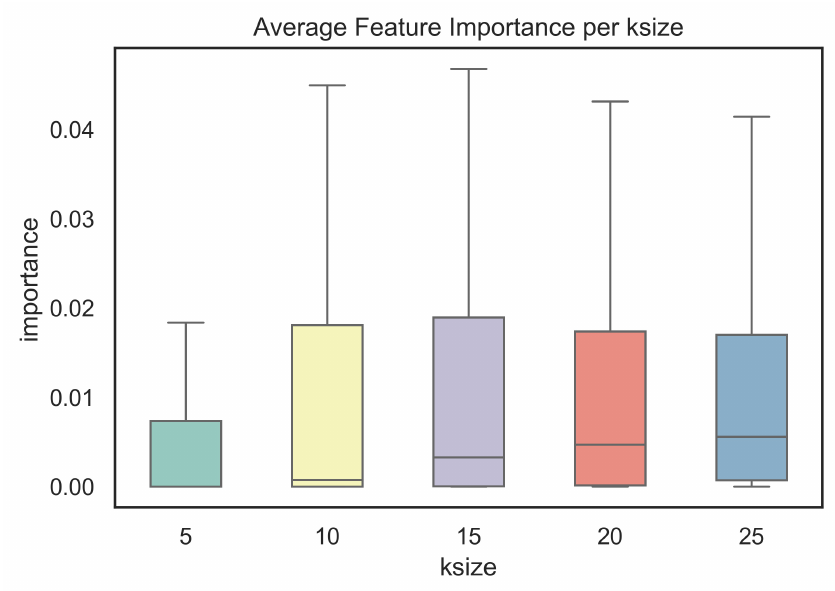
Figure 12. The boxplot for different ksizes. It indicate that ksize 25 has the higher median and shorter distance, so ksize 25 is the best among the 5 different